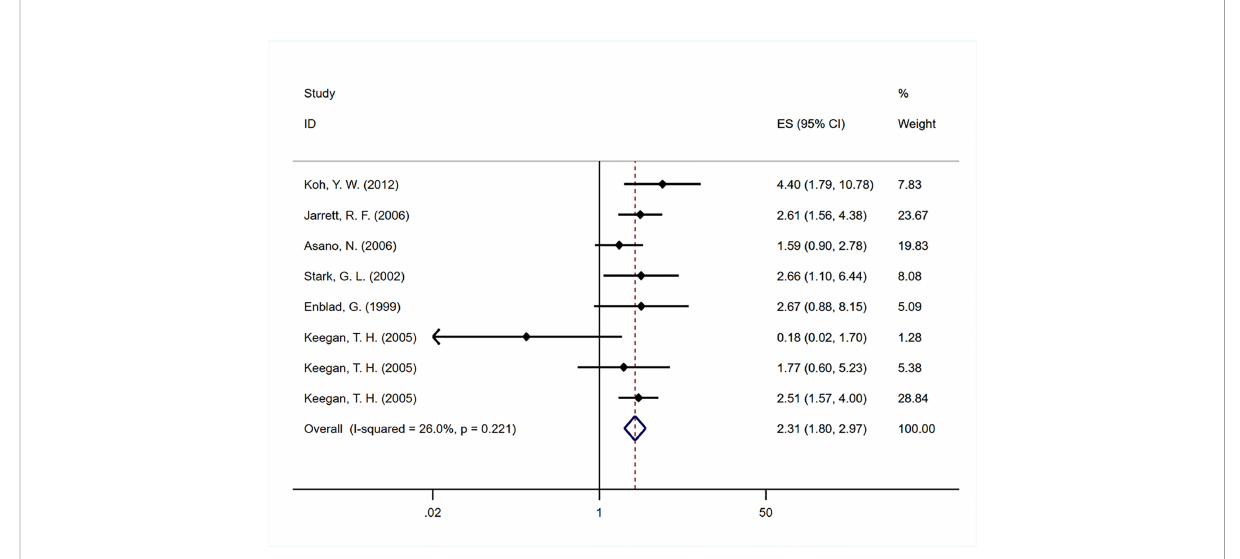
FIGURE 6 Forest plot of the hazard rations for disease-speci fi c survival (DSS) between patients with EBV-positive and EBV-negative